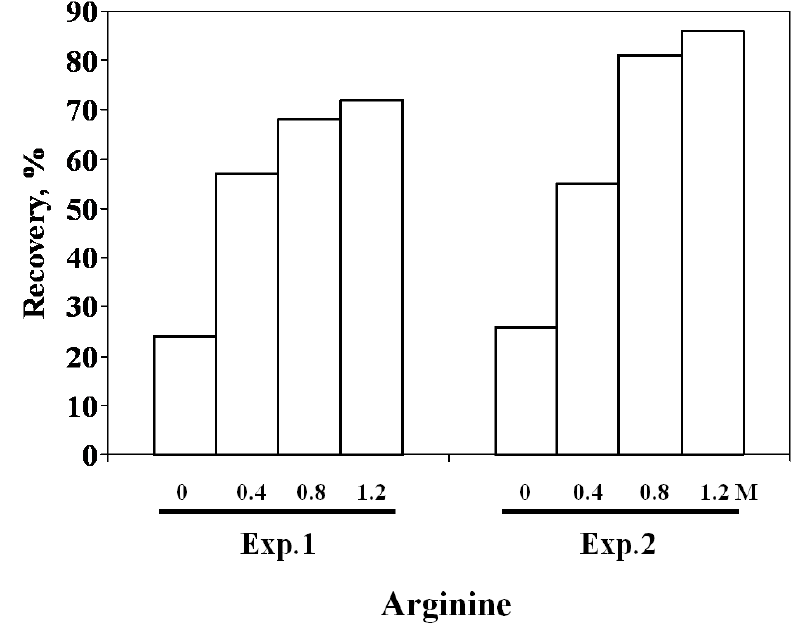
Figure 6. Effect of arginine on refolding of transglutaminase by C12- L